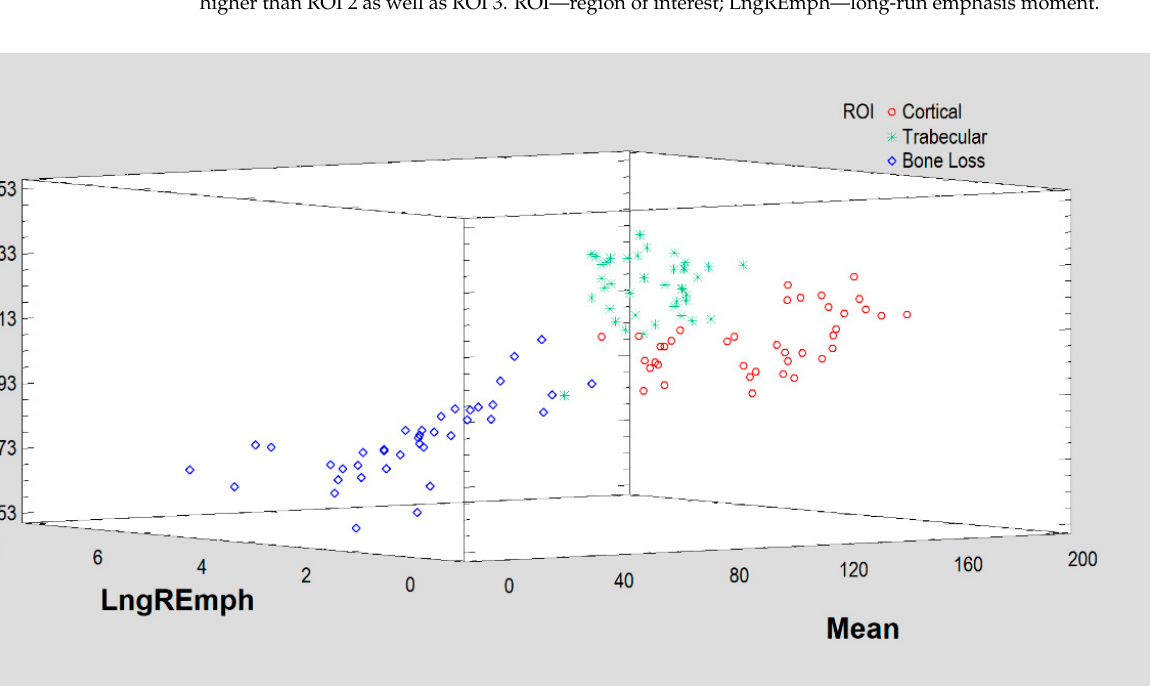
Figure 4. The bone index (BI) was calculated for the detection of normal bone (i.e., trabecular bone) within dental alveolus during guide bone regeneration. That is why BI reaches the highest values in ROI 2 representing trabecular bone. There are significant statistical differences between each ROI.